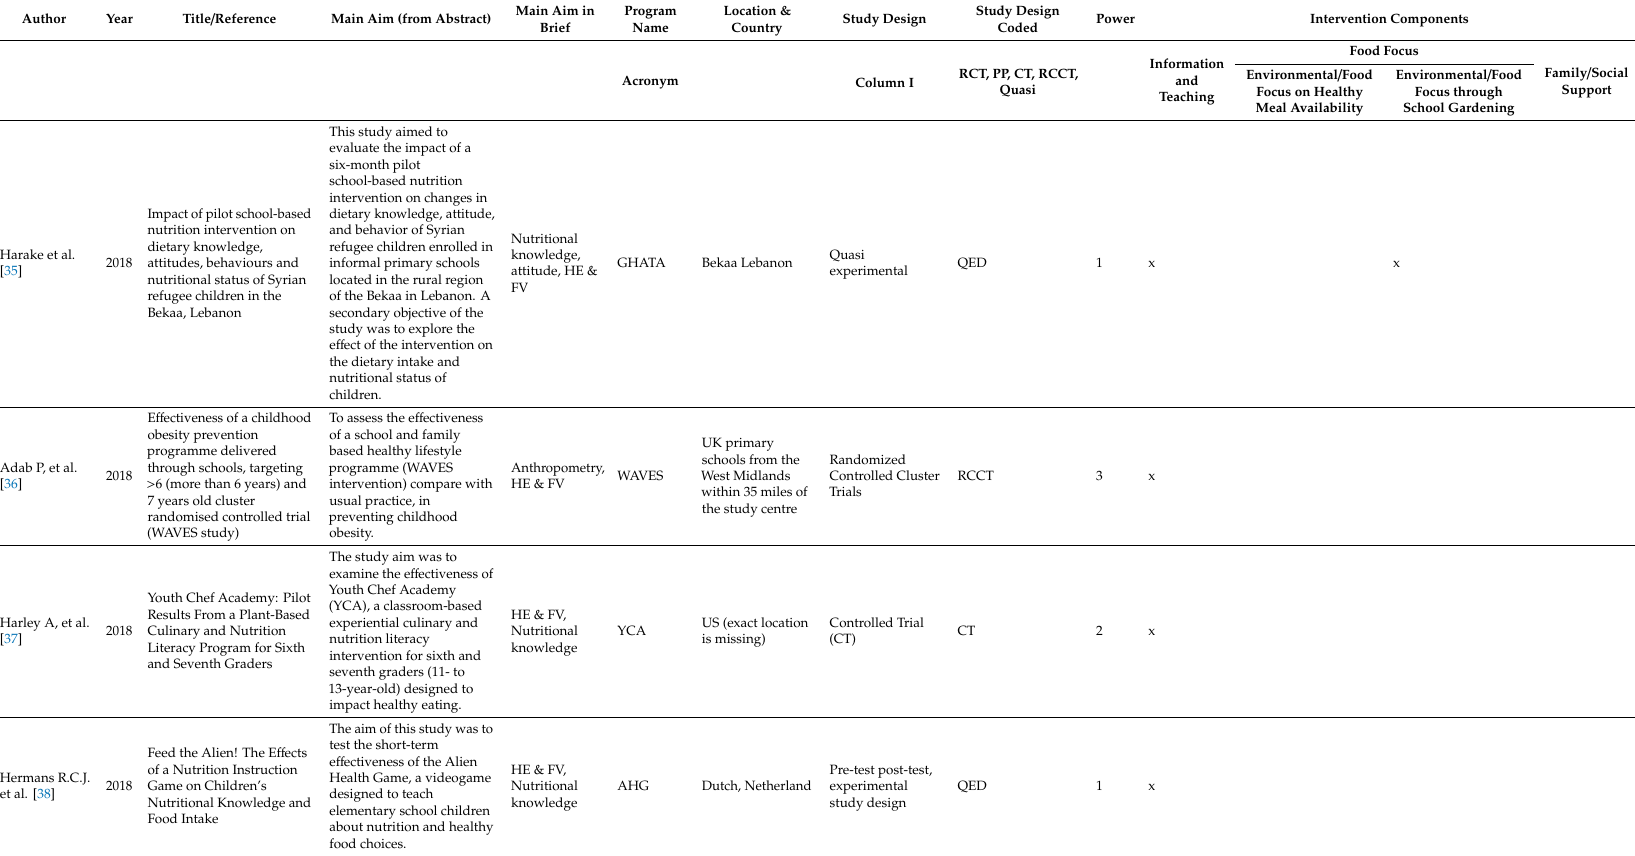
Table 2. The review sample: study design / characteristics. The table shows the 43 studies of the review Illustrating study design and study characteristics of the included